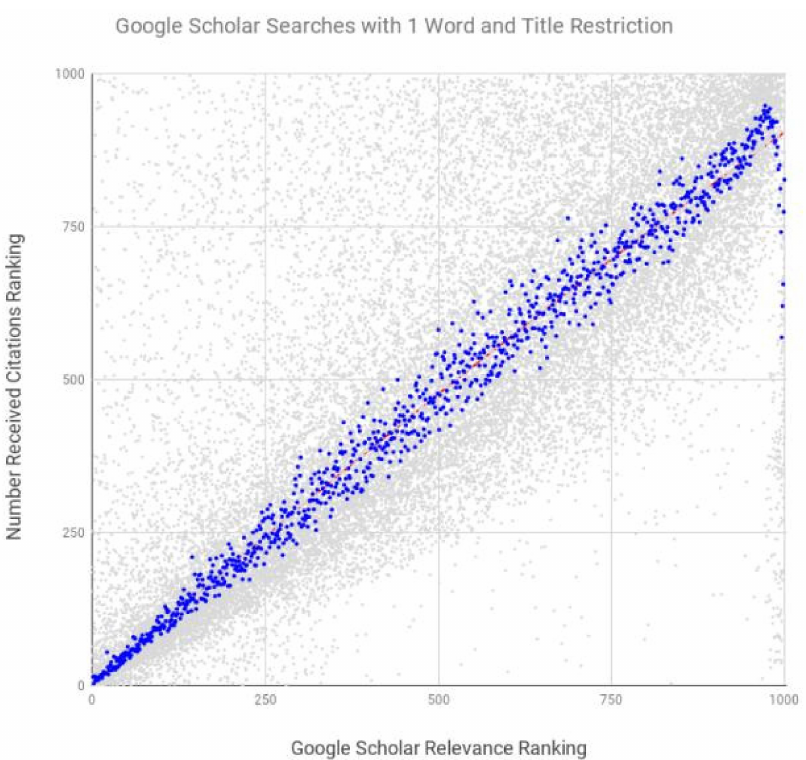
Figure 3. Google Scholar Searches with One Word and Title Restriction (rho 0.990, median in blue, the rest of data in gray).